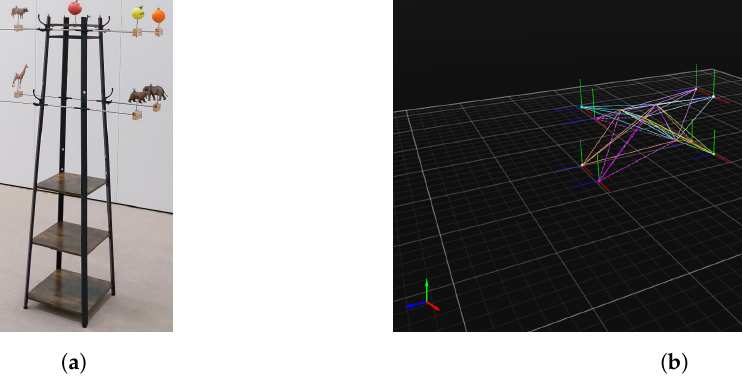
Figure 2. ( a ) Toy Example illustrates the toy example, which is a model of an electric power pole that uses lifelike figures of animals, fruits, and sports equipment, which correspond to 9 distinct labels in the MS COCO dataset. ( b ) Screenshot from MoCap’s tracking software shows the tracked toy example in the MoCap’s tracking software. Best viewed as PDF and in